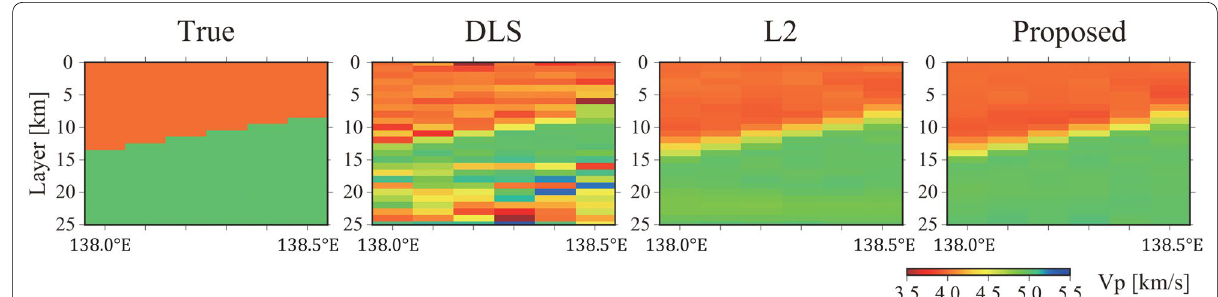
Fig. 9 Vertical and horizontal variations in the true and estimated velocity structures obtained using DLS, l 2 -smoothness regularization (L2), and the proposed method